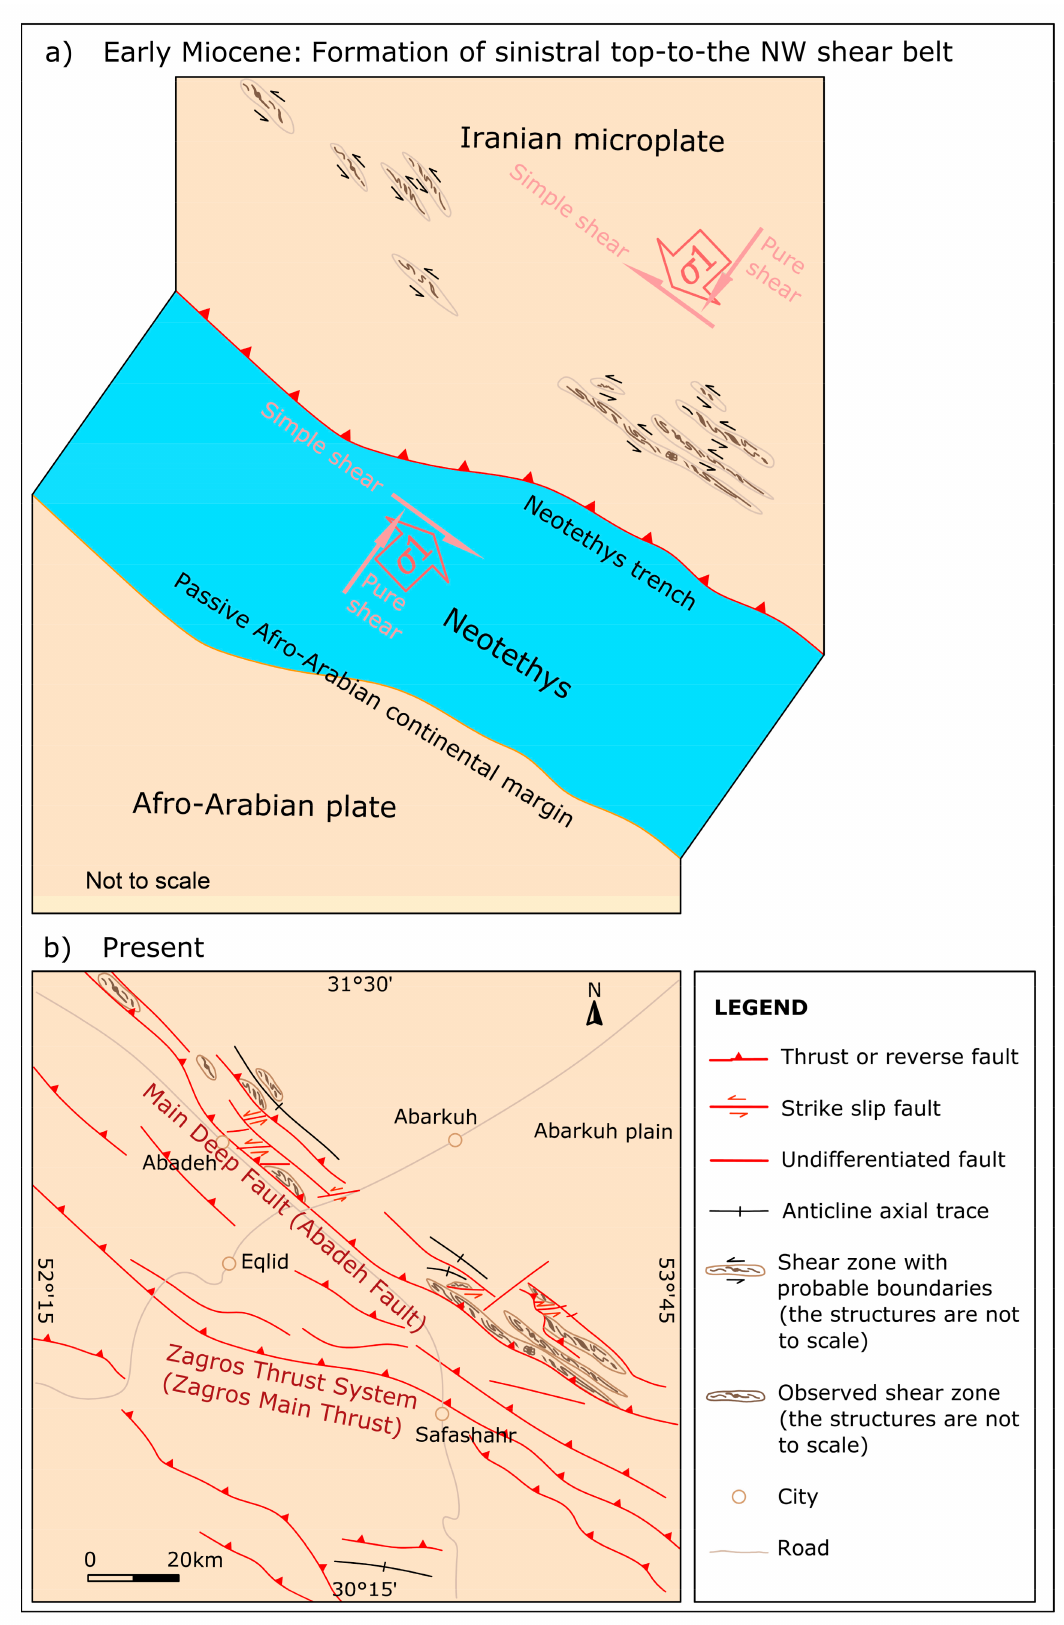
Figure 9. Diagrams showing the plate tectonic evolution of the study area. ( a ) The development of the sinistral top-to-the NW shear belt in the Early Miocene; ( b ) The present